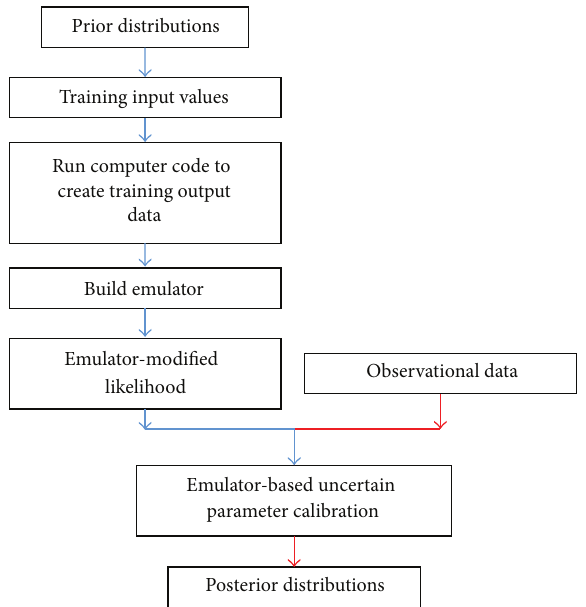
Figure 1: Emulator-based Bayesian calibration flow chart.